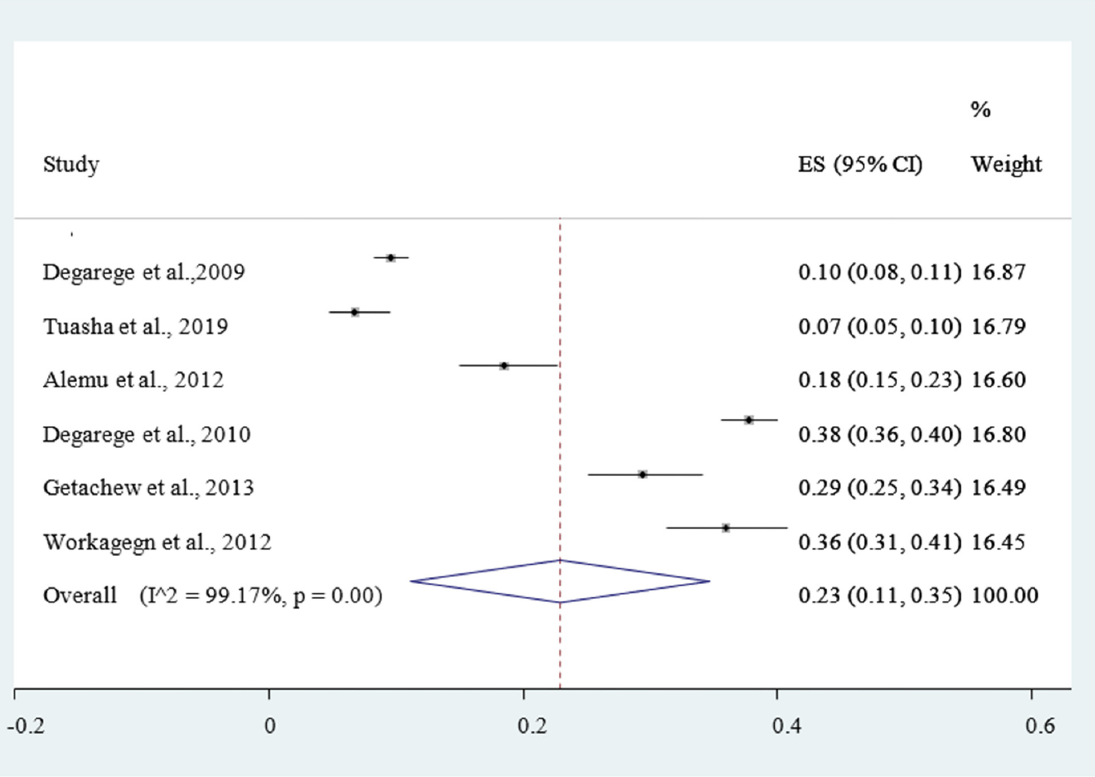
Figure 6. Forest plot of 4 studies on magnitude of Plasmodium falciparum and Plasmodium vivax mixed infection among outpatients in Ethiopia, 2020.